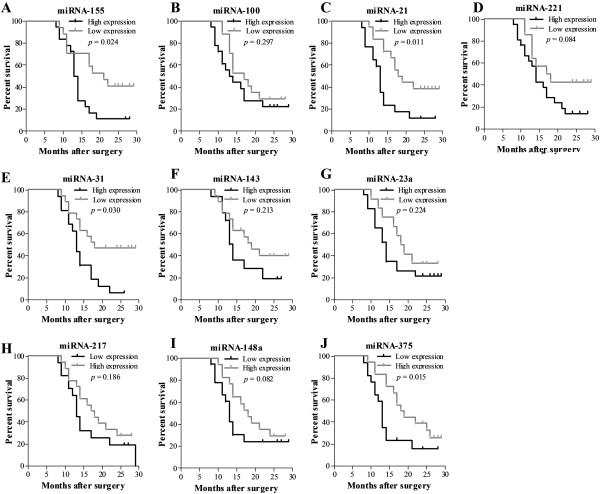
Kaplan-Meier analysis of overall survival in patients with PDAC based on their expression of miR-155 (A), miR-100 (B), miR-21 (C), miR-221 (D), miR-31 (E), miR-143 (F), miR-23a (G), miR-217 (H), miR-148a (I) and miR-375 (J). p-values are based on the log-rank test.